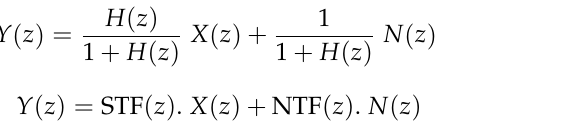
Figure 7. SDM modulator in the z-domain.